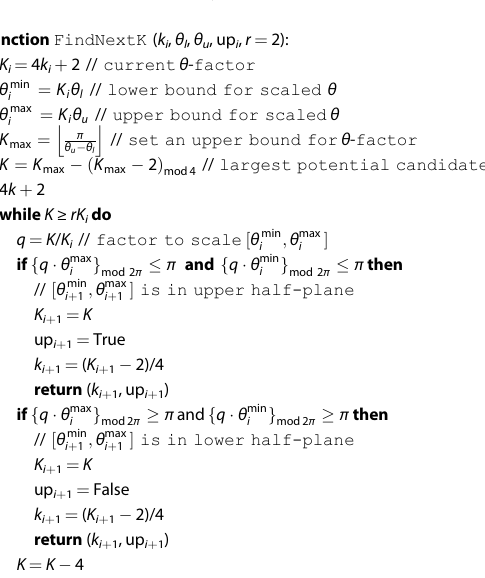
Algorithm 2 Procedure for fi nding k i + 1